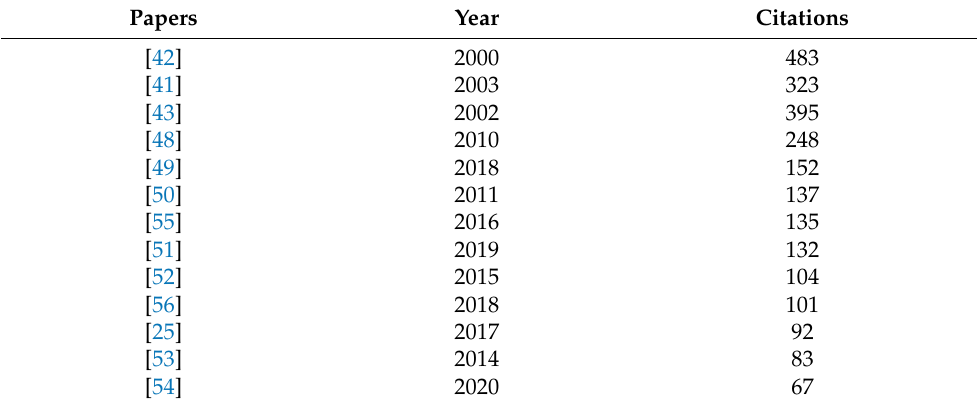
Table 3. Most cited